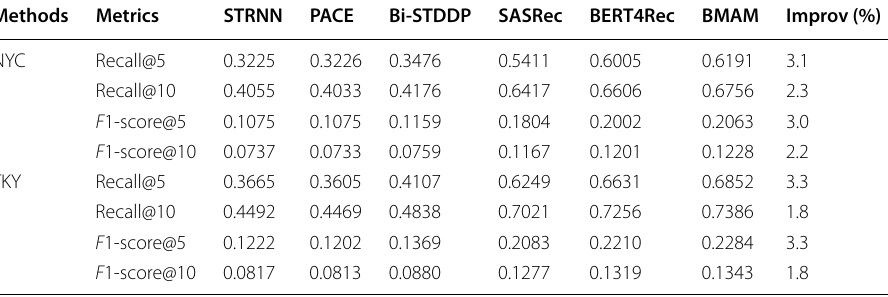
Table 2 Performance of BMAM and baseline on the dataset Methods Metrics